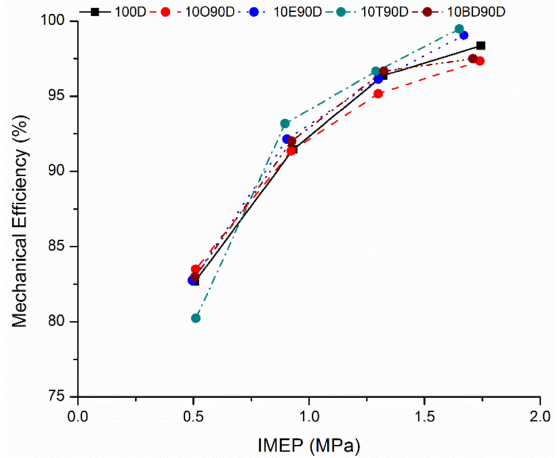
Figure 6. Mechanical Efficiency variation of tested fuel blends.